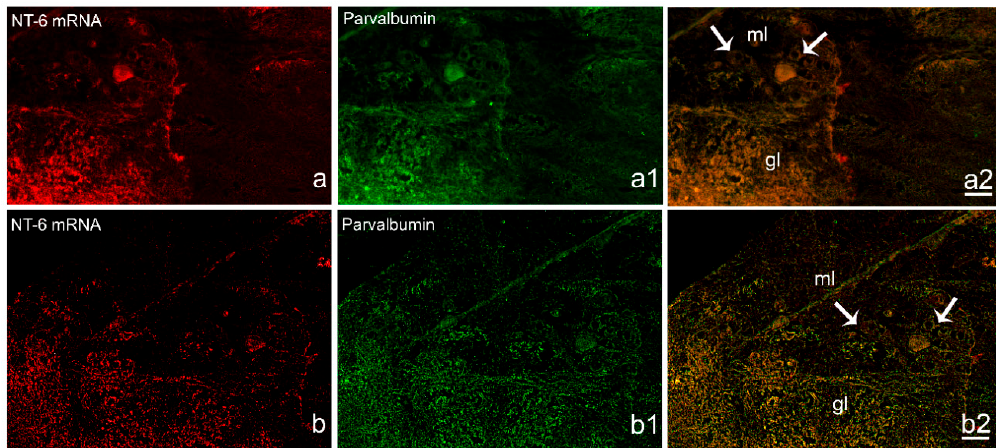
Figure 8. Immunohistochemical characterization of NT-6 mRNA expression in Purkinje cells in sagittal section of cerebellum. ( a , a1 , a2 ) single images and merge of NT-6 mRNA and Parvalbumin positive cells, showing co-staining in the gl and in Purkinje cells (arrow). ( b , b1 , b2 ) higher magnification of single images and merge of NT-6 mRNA and Parvalbumin positive cells showing co-staining in the gl and in Purkinje cells (arrow). Scale bar: a = 50 µ m; b = 25 µ m. Abbreviation: gl, granular layer; ml, molecular layer.